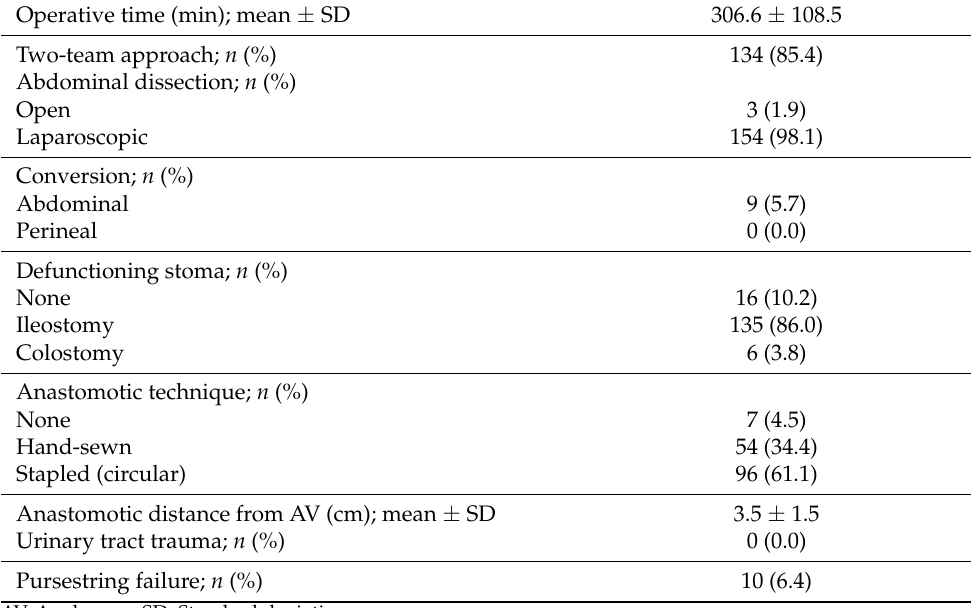
Table 2. Intraoperative data ( n =